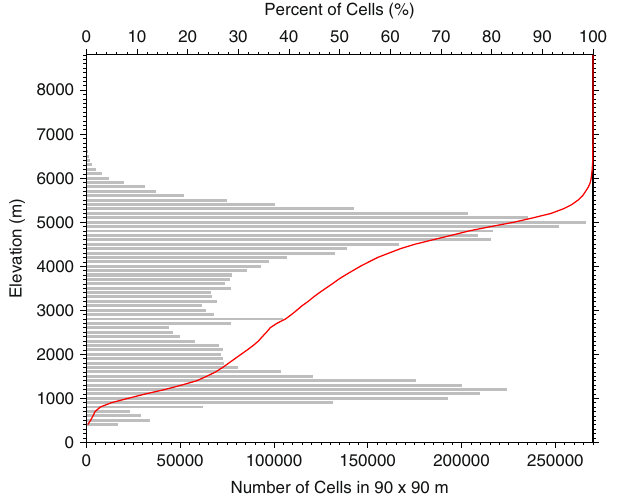
Figure 1. Histogram of elevation in 100 m interval (gray bars) and hypsometric curve (red line) for the Tibetan Plateau and the surroundings (TPS, 25 °N–42 °N and 77 °E–105 °E) based on the 90 m resolution digital elevation map. This figure was plotted using the Generic Mapping Tools (GMT) V4.5.0 (https://www.soest.